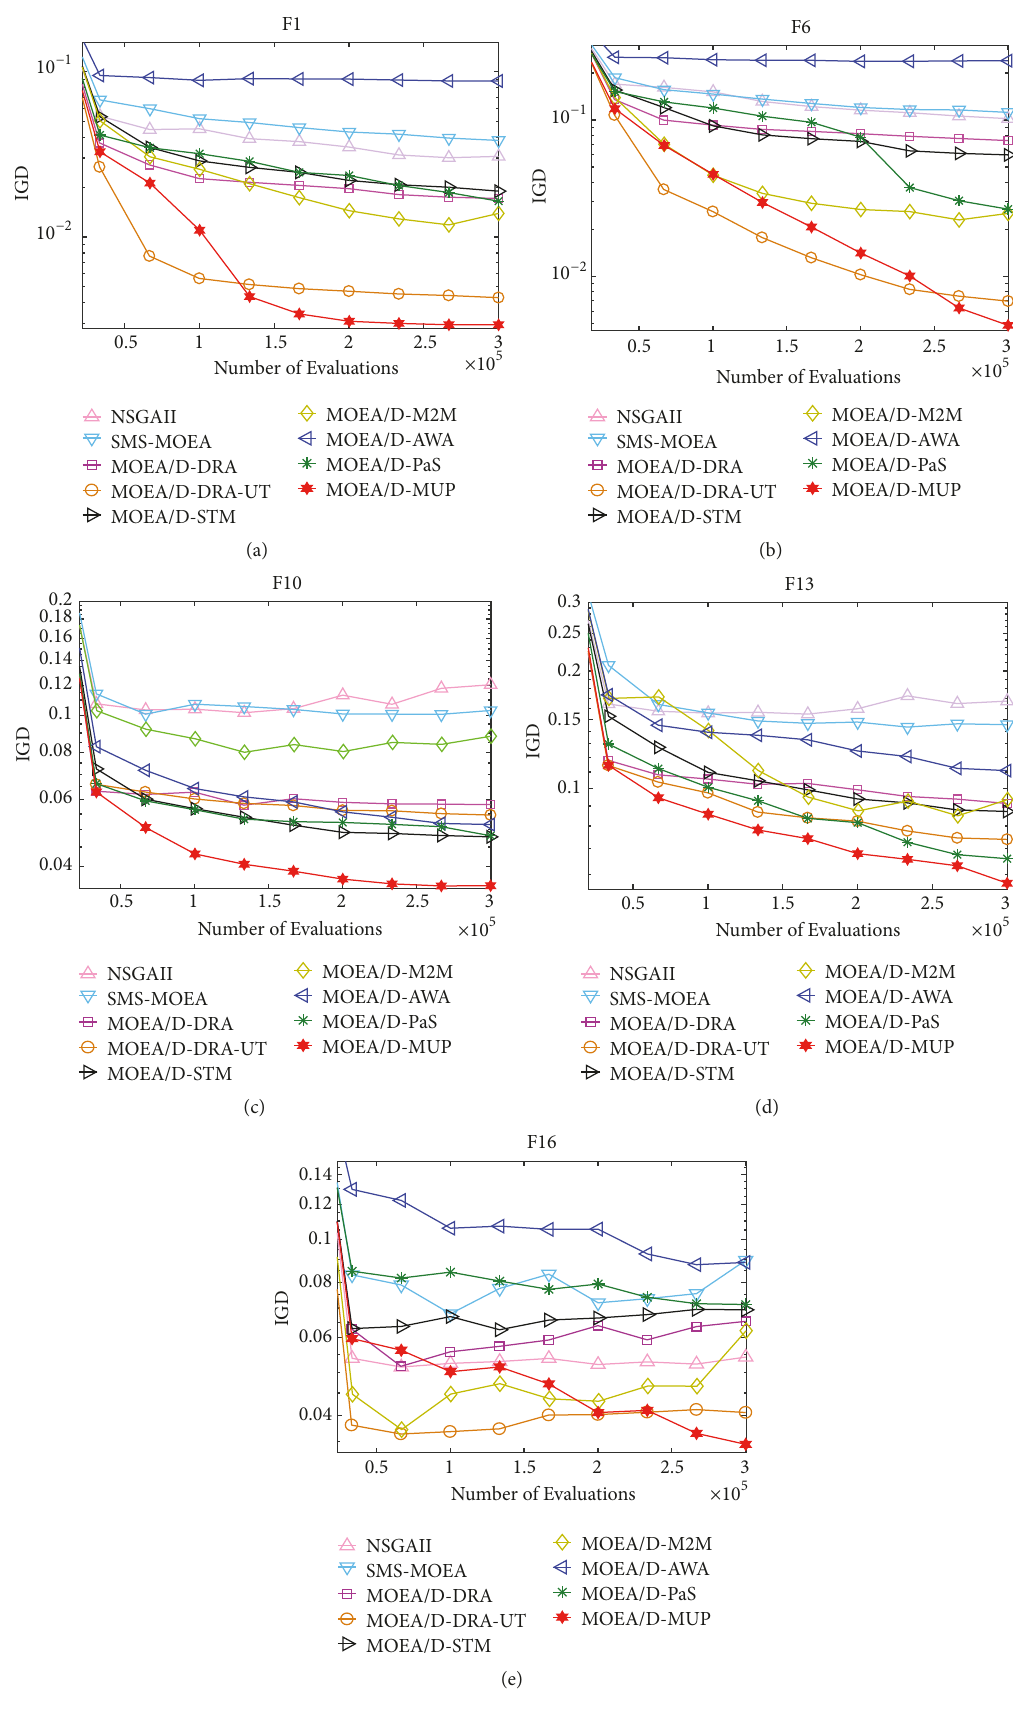
Figure 7: The convergence curves of all the compared algorithms on (a) F1, (b) F6, (c) F10, (d) F13, and (e)